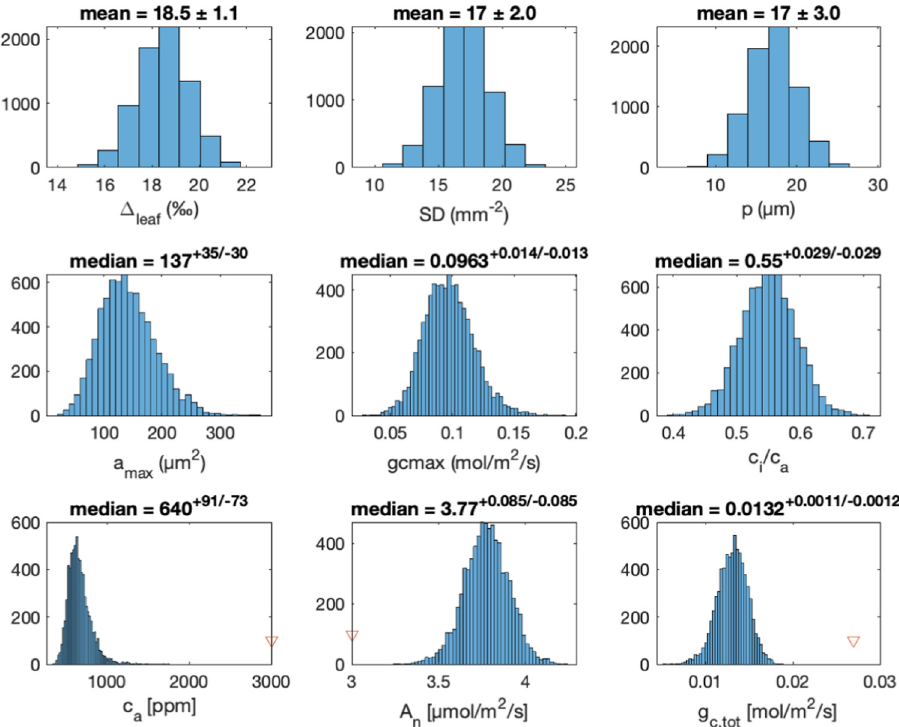
Fig. 2 | Error propagation of the mechanistic pCO 2 proxy applied to Givetian Drepanophycussp .fromtheHamiltonGroup,NY,USA. Probabilitydistributions for model input parameters ( Δ leaf , SD, p; upper row) are sampled ( N =10,000) to calculate model parameters (middle row: stomata area, a max , the maximal con- ductance at full daylight, g c,max , and ratio of CO 2 concentration in the substomatal cavities to atmospheric CO 2 , c i /c a ;) and posterior probability distributions for the